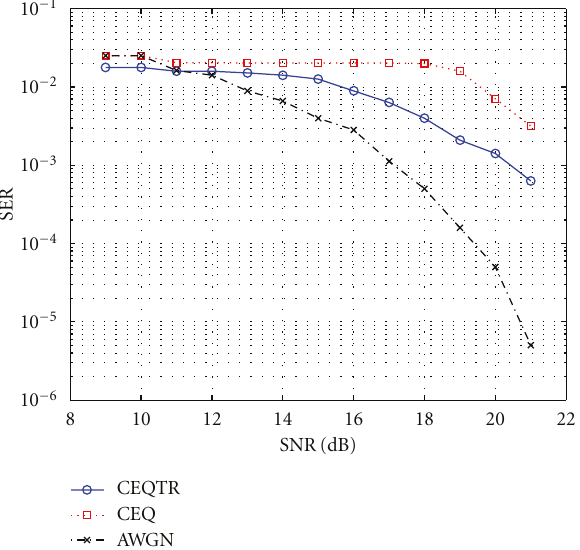
Figure 5: CEQ and CEQTR SER × SNR under “Brazil A” channel profile, no Doppler rotation applied. L , FIR init, η CMA , and η DD as in Figure 2. AWGN refers to the CEQTR output SER for an AWGN [6] channel.